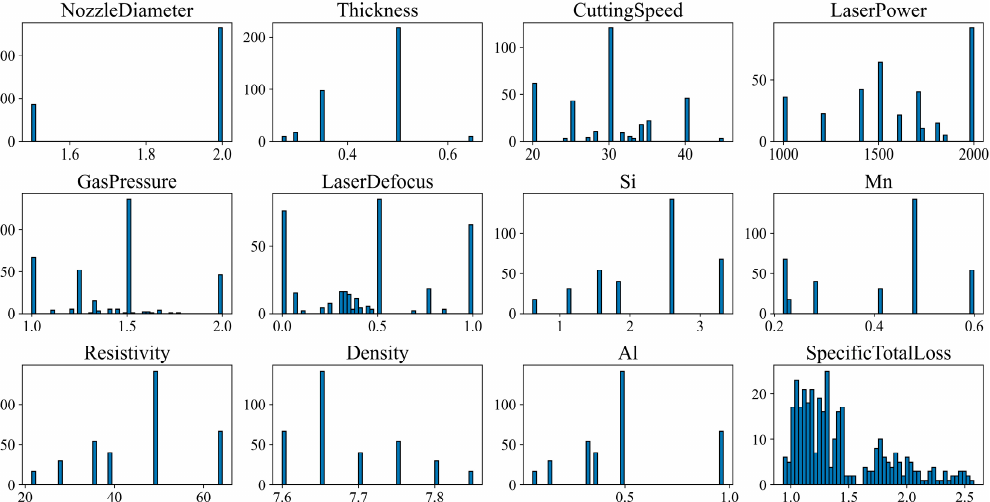
Figure 3. Data distribution of the collected dataset. The X -axis is the value range of the specific feature and the Y -axis shows the accumulative number of the samples at each value of the features. Units: sample density, g/cm 3 ; laser nozzle diameter (NozzleDiameter, mm); cutting speed (CuttingSpeed, m/min); laser power (LaserPower, W); process gas pressure (GasPressure, MPa); laser defo- cus (LaserDefocus, mm), the steel sheet thickness (Thickness, mm); Si, Al and Mn, wt%; resistivity, µ Ω ·cm and the speci fi c total loss (Speci fi cTotalLoss, W/kg).